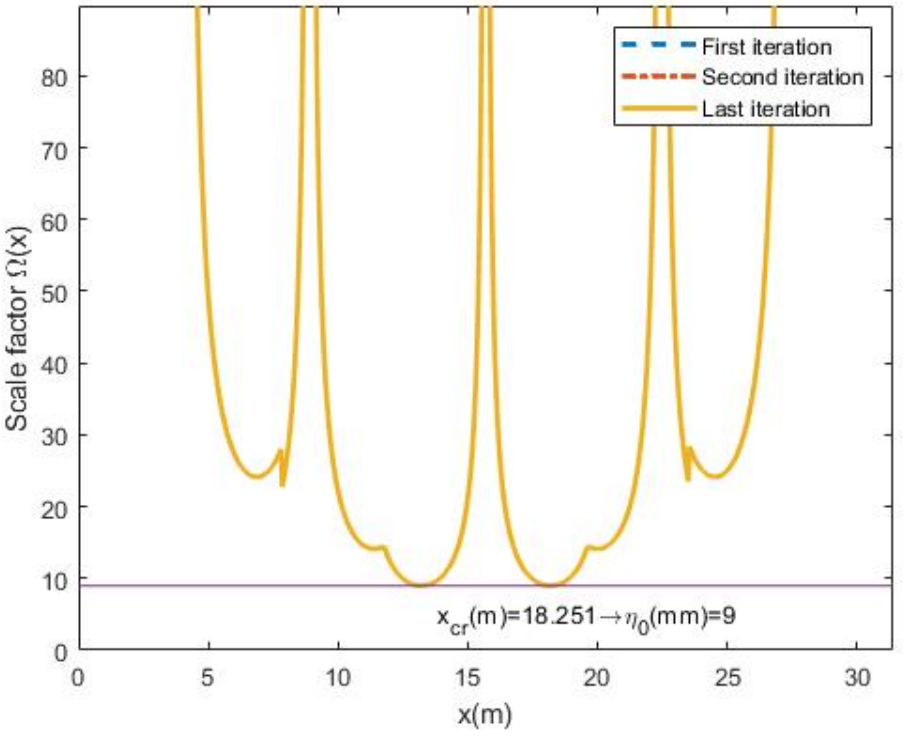
Figure 6. Example 2: UGLI imperfection η init , bending moment M , shear force V , and utilization factor U . Values in brackets are from [7].